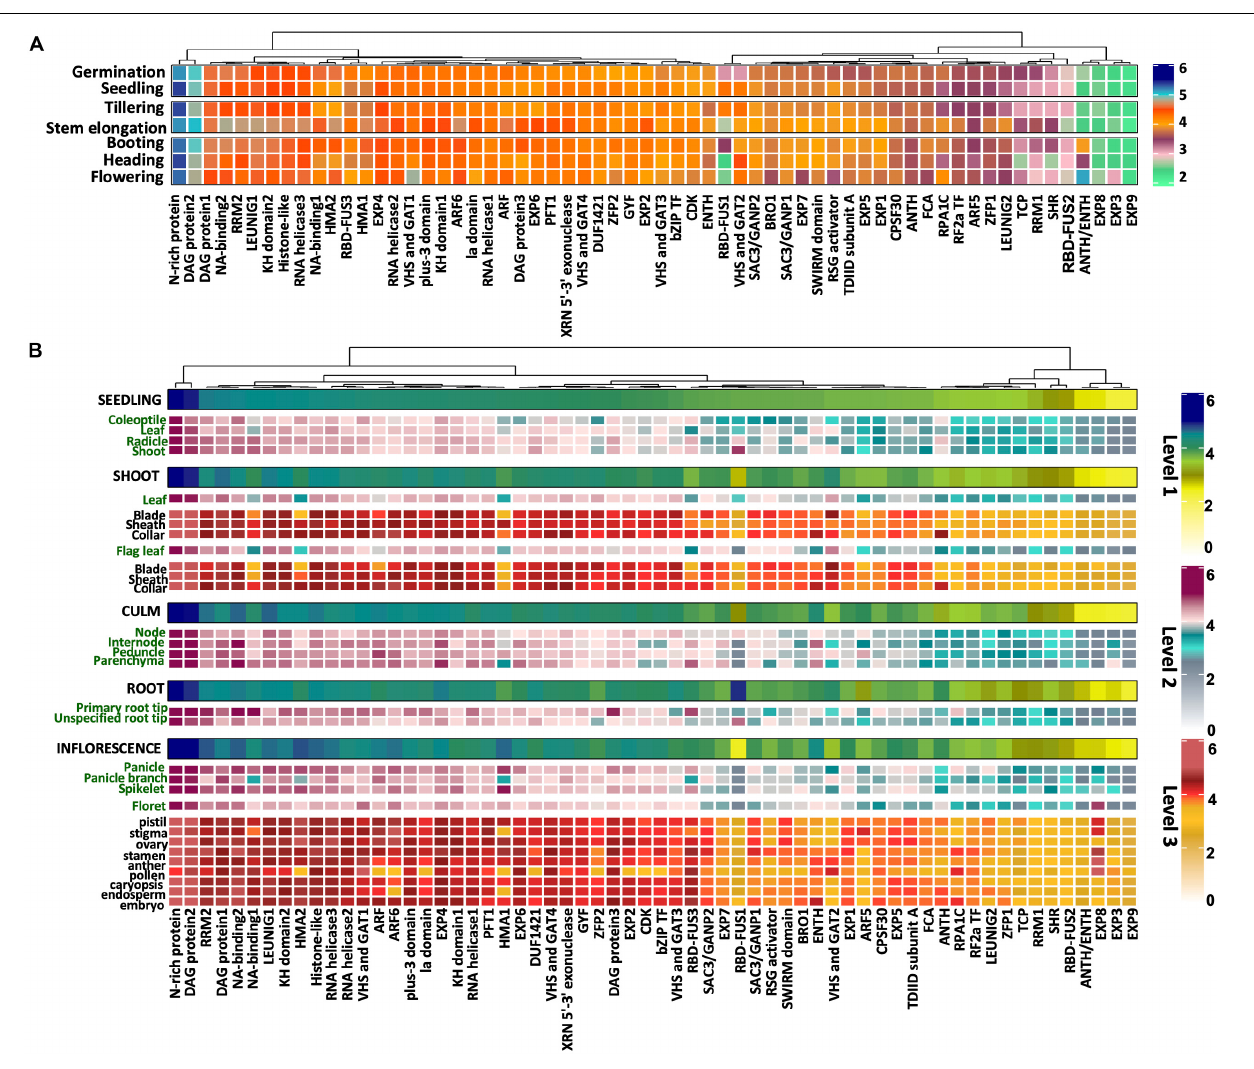
FIGURE 3 | Differential expression of rice prionome across (A) developmental stages and (B) across specific organs and tissues of rice. Expression profile has been depicted in organs (first level), their parts (second level), and different tissues (third level) within these parts. The profile of each of the three levels has been indicated by a different colored scale. Data are shown for 62 PrLPs obtained from Genevestigator. For full names and accession IDs, refer to Supplementary Table 5